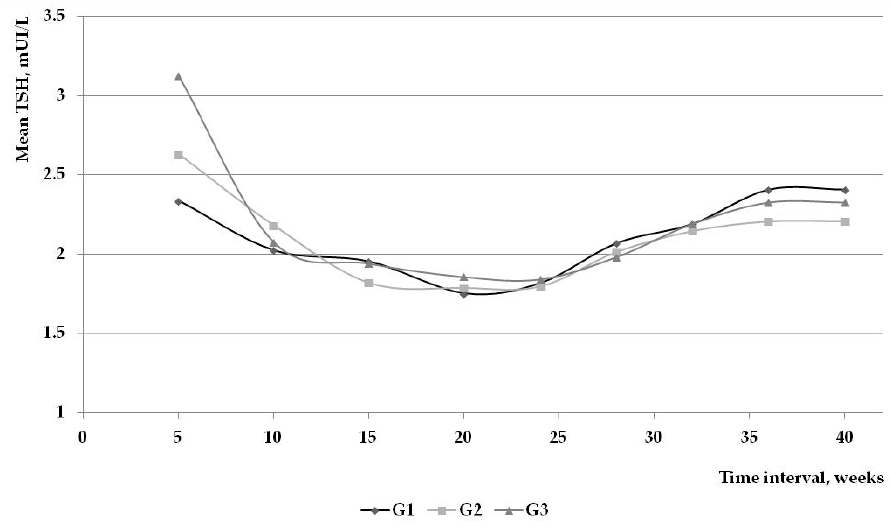
Figure 5. Evolution of mean TSH in the 3 subgroups.